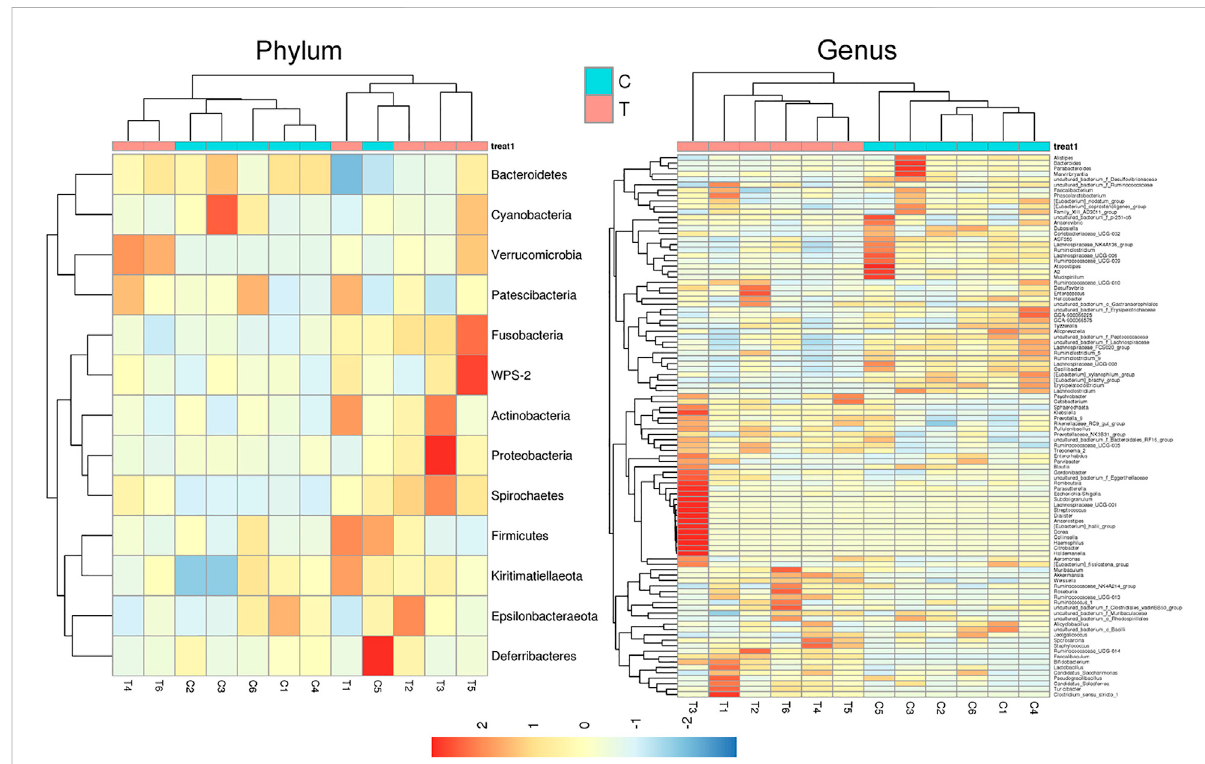
FIGURE 6 Microbial diversity clustering. (A) Phylum-level analysis; therelativeabundanceof Actinobacteria and Verrucomicrobia inthe CHMACS-treated group was signi fi cantly higher than that in the control group. (B) Genus-level analysis; the relative abundance of Turicibacter , Faecalibaculum , Lactobacillus , and Bi fi dobacterium in the CHMACS-treated group was signi fi cantly higher than that in the control